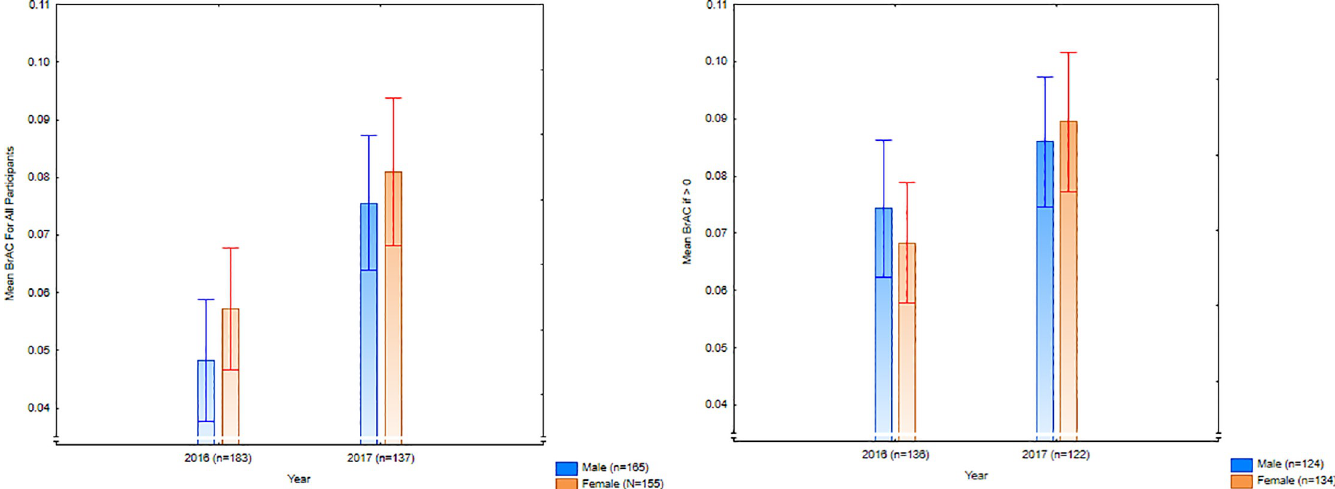
Fig 1. Entry mean breath alcohol concentration (with 95% confidence intervals) for the big night out, both before (2016) and after (2017) the legislative changes.